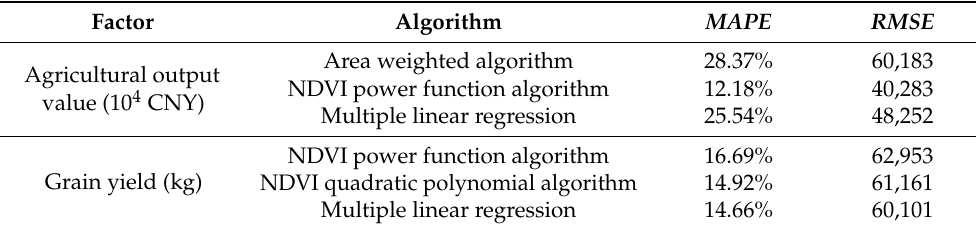
Table 7. Simulation performance of regression